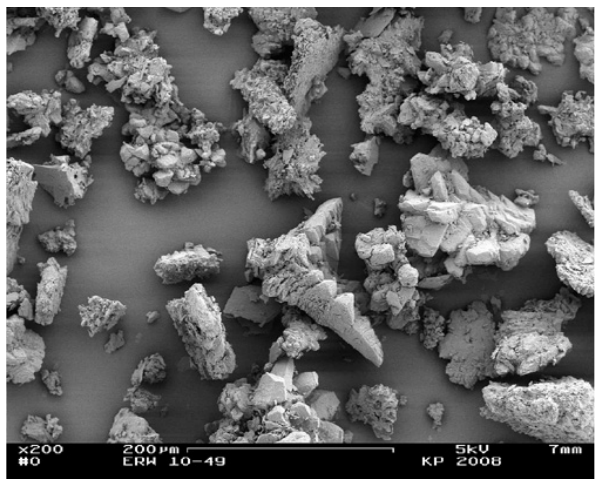
Fig. 4. SEM image of calcitic residue retrieved from the ice core drilled in the Eispalast at a depth of 260cm consisting of diverse crystal aggregates and fragments